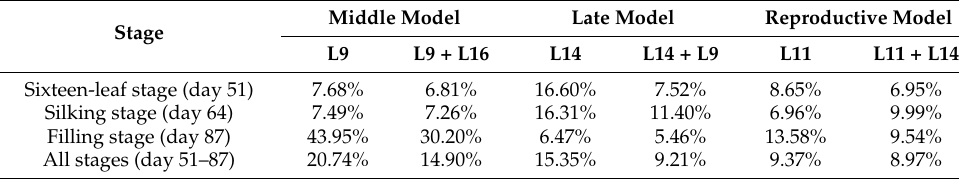
Table 5. Verification of the stepwise regression model in